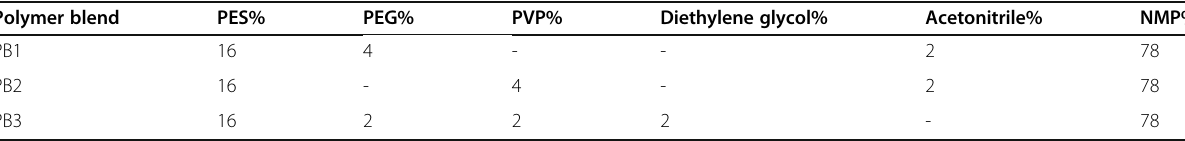
Table 1 Polymer blends composition Polymer